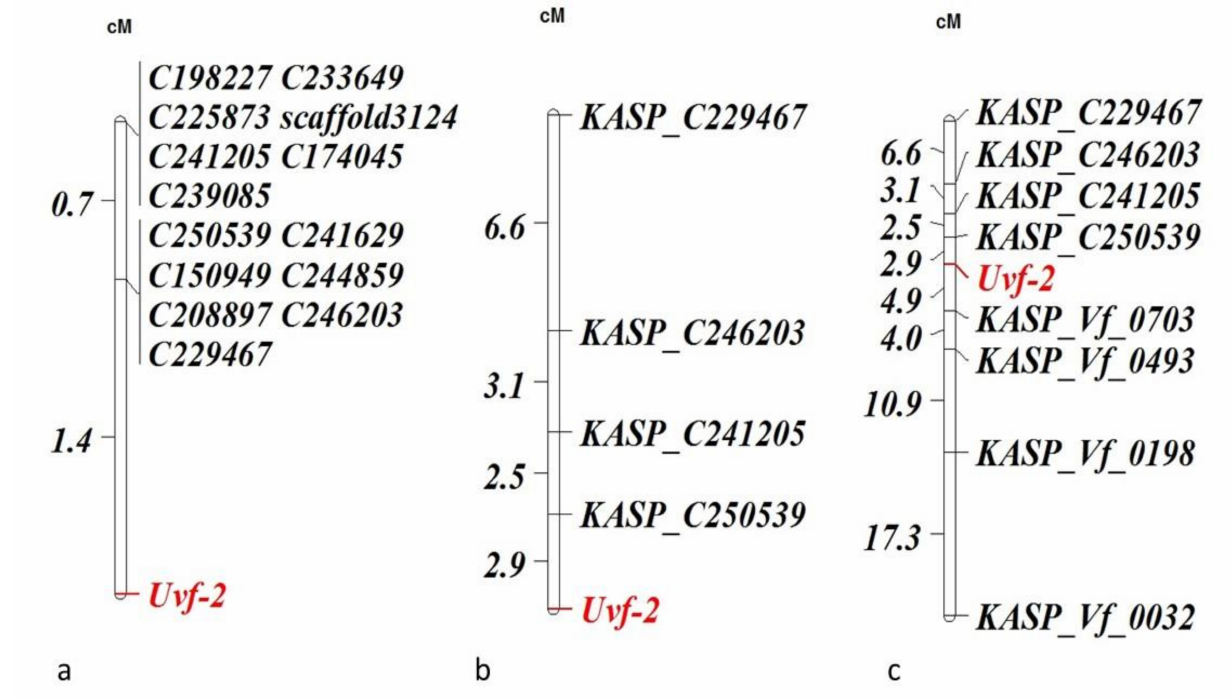
Figure 3. Linkage maps of chromosome III of Fiord/Doza#12034 population showing association of markers linked with rust resistance gene Uvf-2 : ( a ) constructed from SNPs identified through GBS-t (88 RILs), ( b ) based on KASP markers developed for SNPs detected from GBS-t and ( c ) joint linkage map constructed with KASPs derived from 1536 Illumina and